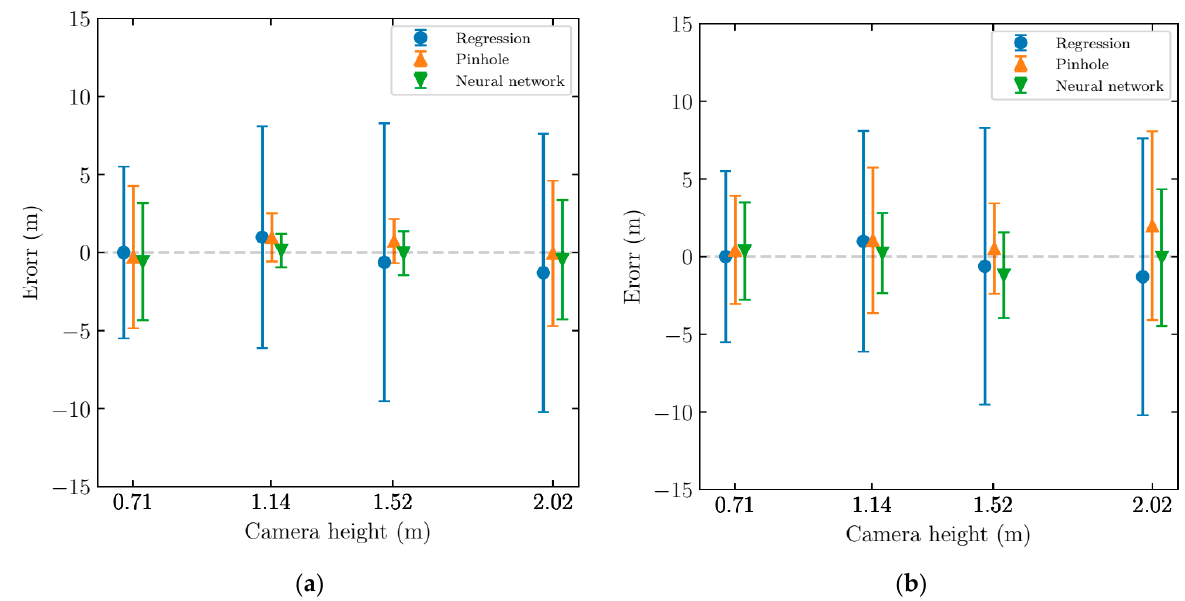
Figure 8. Camera-based distance estimation error for various trials and different units: ( a ) sedan; ( b ) pickup truck. Table 1. Comparison of distance estimation error for the three candidate models.